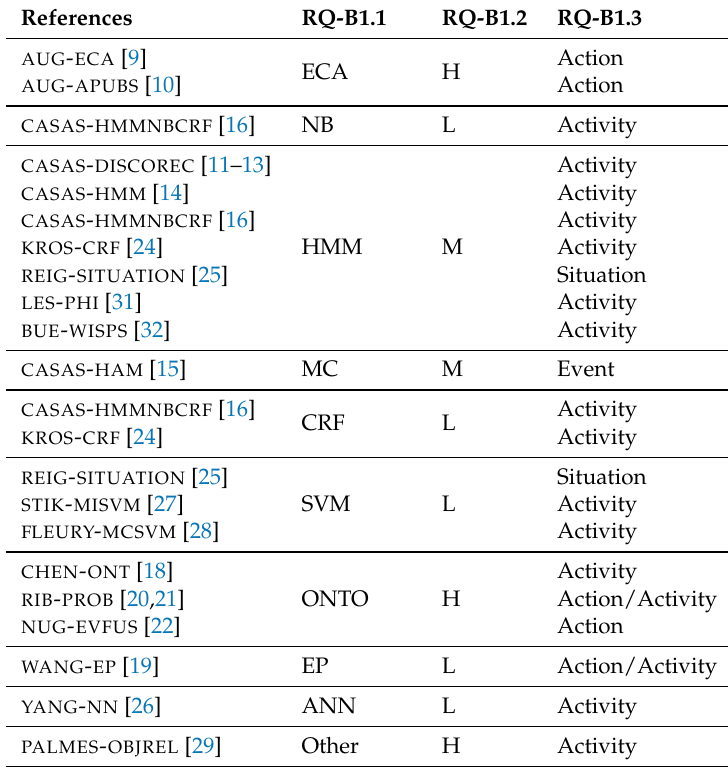
Table 3. Model type (L—Low, M—Medium, H—High)—RQ-B1.1: The type of model—RQ-B1.2: Human Readability Level—RQ-B1.3: Granularity